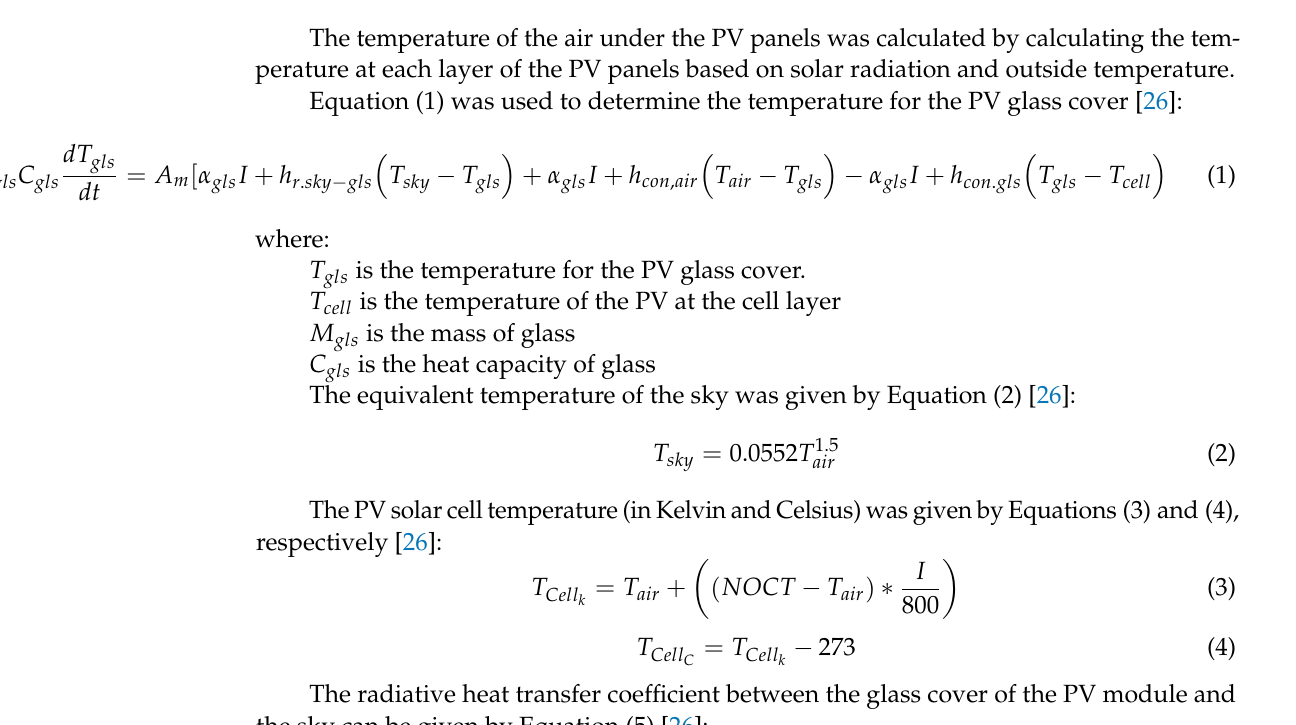
Table 2. Properties of material used in PV-SCPP system. Material Transmissivity ( τ ) Emissivity ( ε ) Absorptivity ( α ) Glass 0.90 0.90 0.05 Water 0.90 0.95 SCPP Base PV